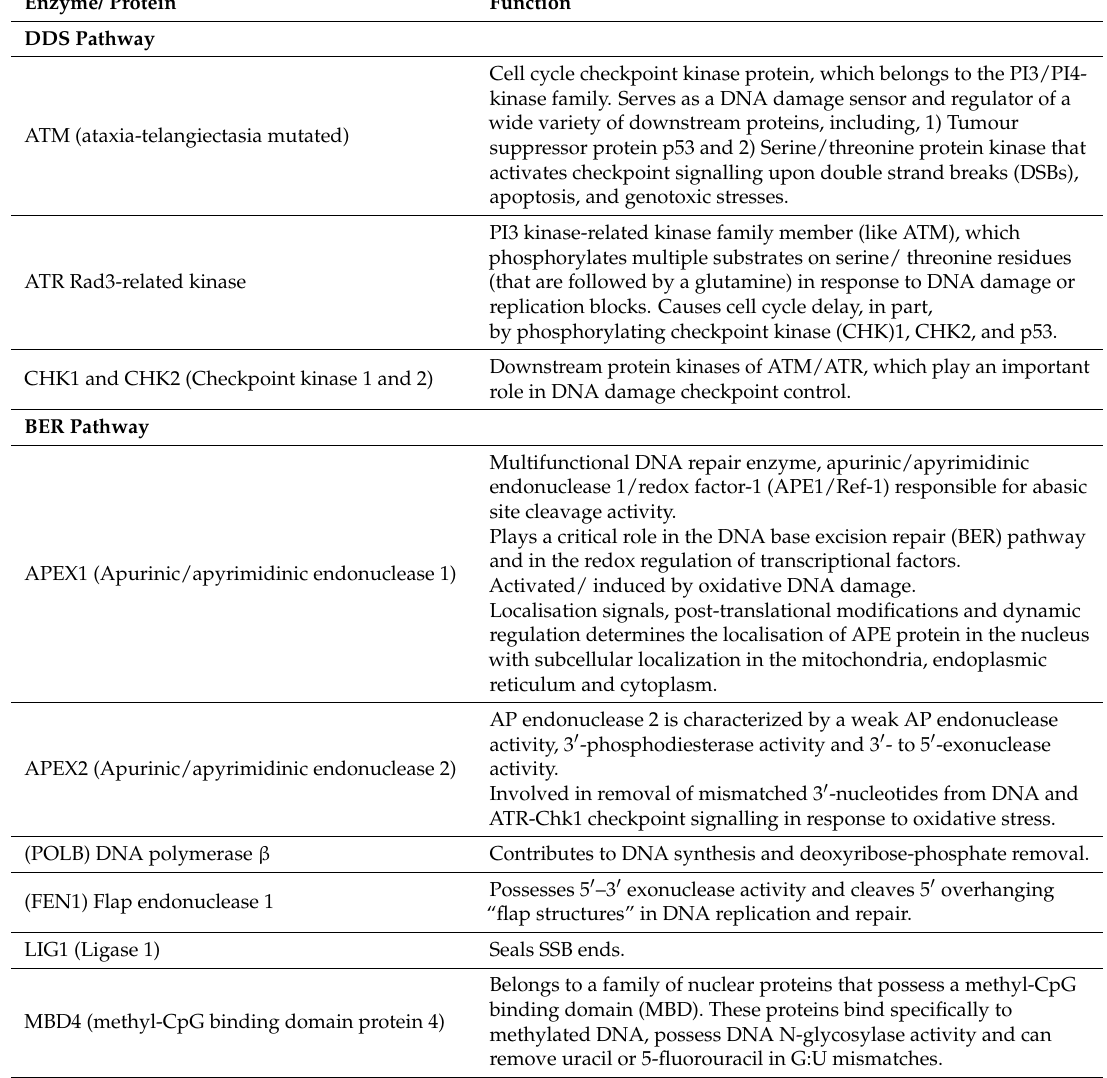
Table 2. Function of important enzymes/proteins involved in the major DNA repair